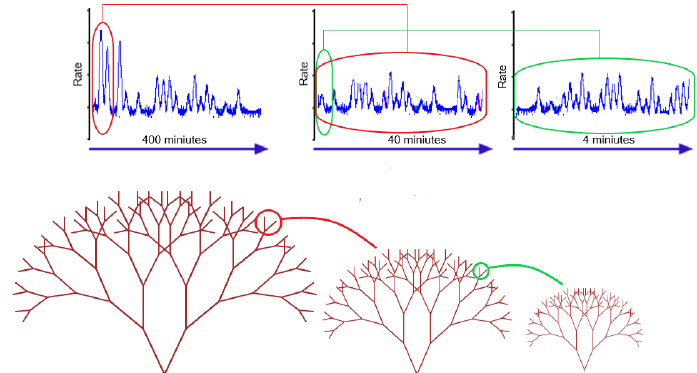
Figure 3. Basic principle of auto-replication (self-similar) dynamics. The tree-like structures (bottom), identified here as spatial fractal comprise branches disposed in a self-similar process that couples with a fractal temporal process, the regulation rates (top), which generate different fluctuations based on variable time scales. The said fluctuations are also shown be statistically